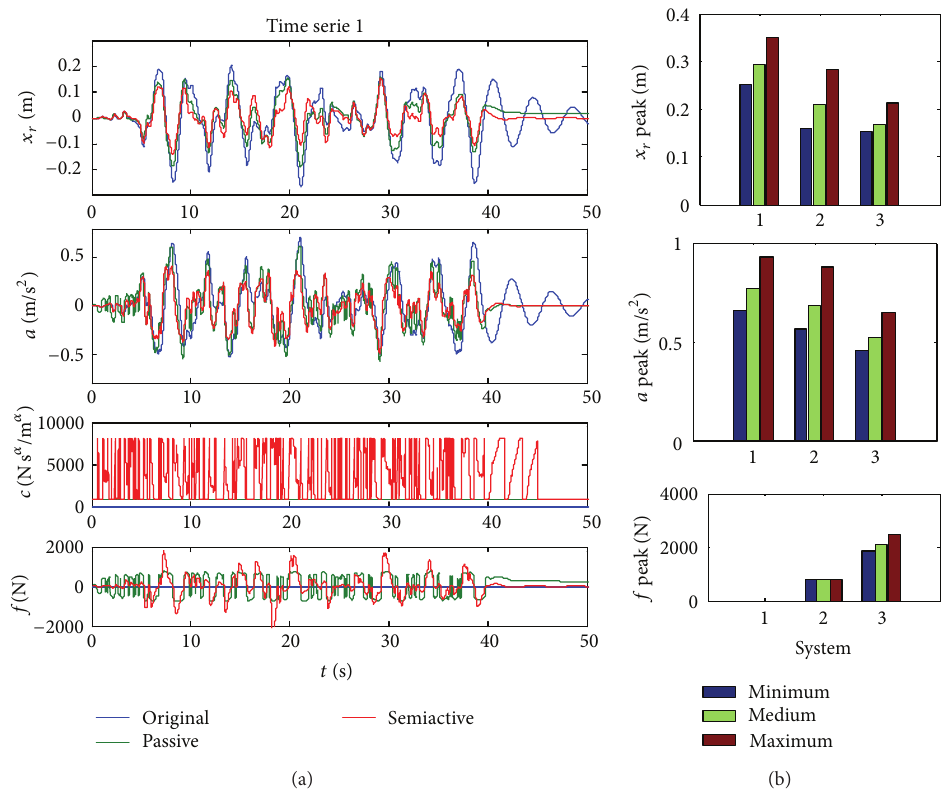
Figure 5: (a) Simulation results for the SDOF model ( 𝑓 𝑛 = 0.25 Hz and 𝜉 = 10 %) subjected to one type 1 accelerogram without devices, with passive and SAMPCVD; (b) peak values’ statistics for 10 type 1 input time